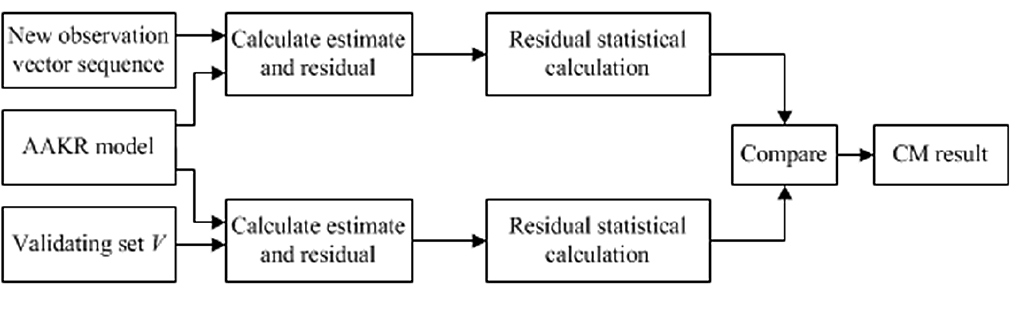
Figure 4. Gearbox condition monitoring using the AAKR